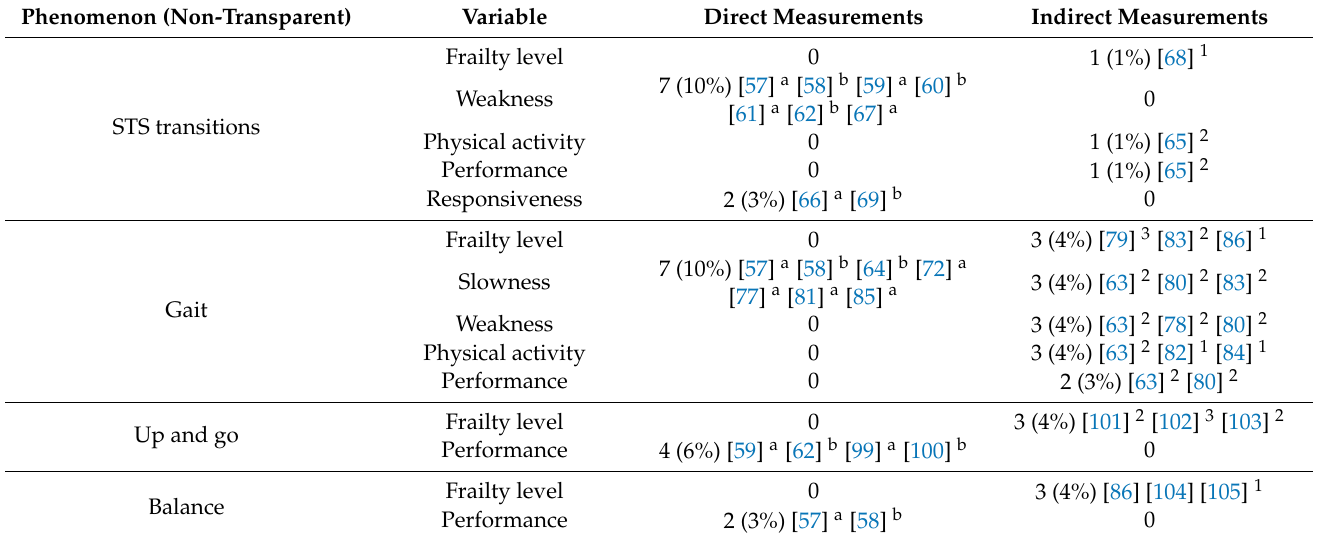
Table 10. Relationships between sensor outcomes (left column) and the target functional variables (second column on the left) for studies relying on non-transparent activities. Studies where the outcome parameters act as a direct measurement for the value of the target variable are listed in the second column on the right. Studies where the outcome parameters act as an indirect measurement for the value of the target variable are listed on the right column. The figures in square brackets are the citations for the corresponding studies. The figures in brackets represent the percentage with respect to the total all 67 studies in the